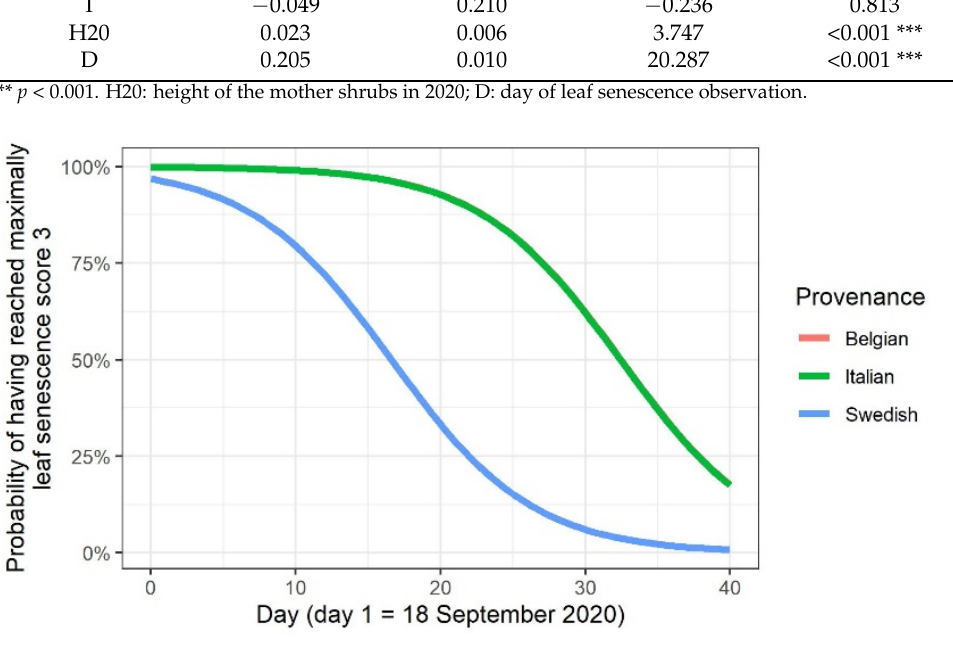
Figure 7. Modelled timing of leaf senescence on the mother shrubs in the autumn of 2020, according to the provenance. Belgian and Italian lines overlap.